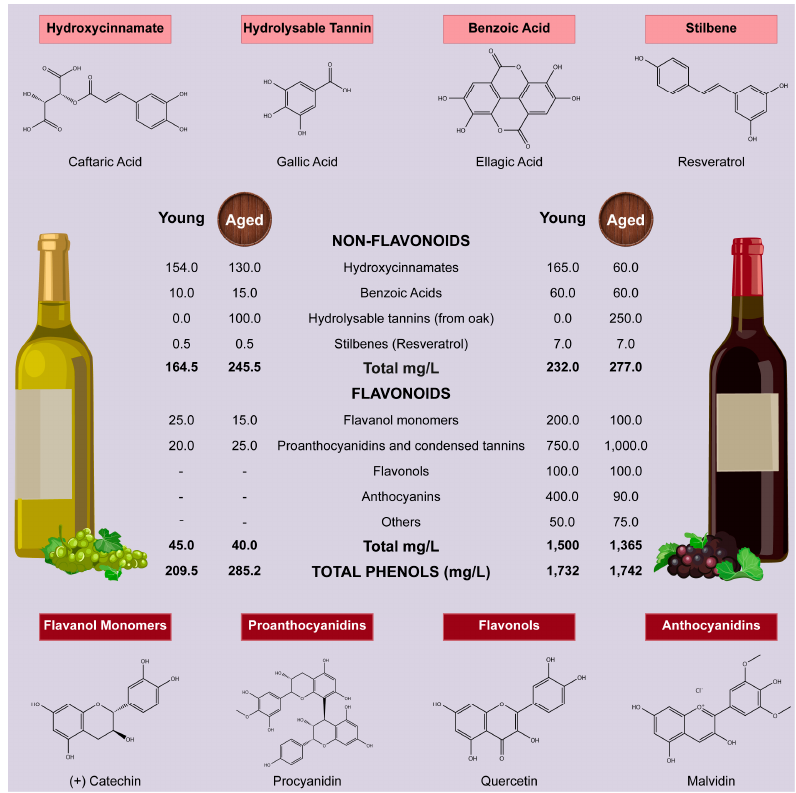
Figure 1. Red and white wine phenolic composition. Adapted from Waterhouse A.L. [16].